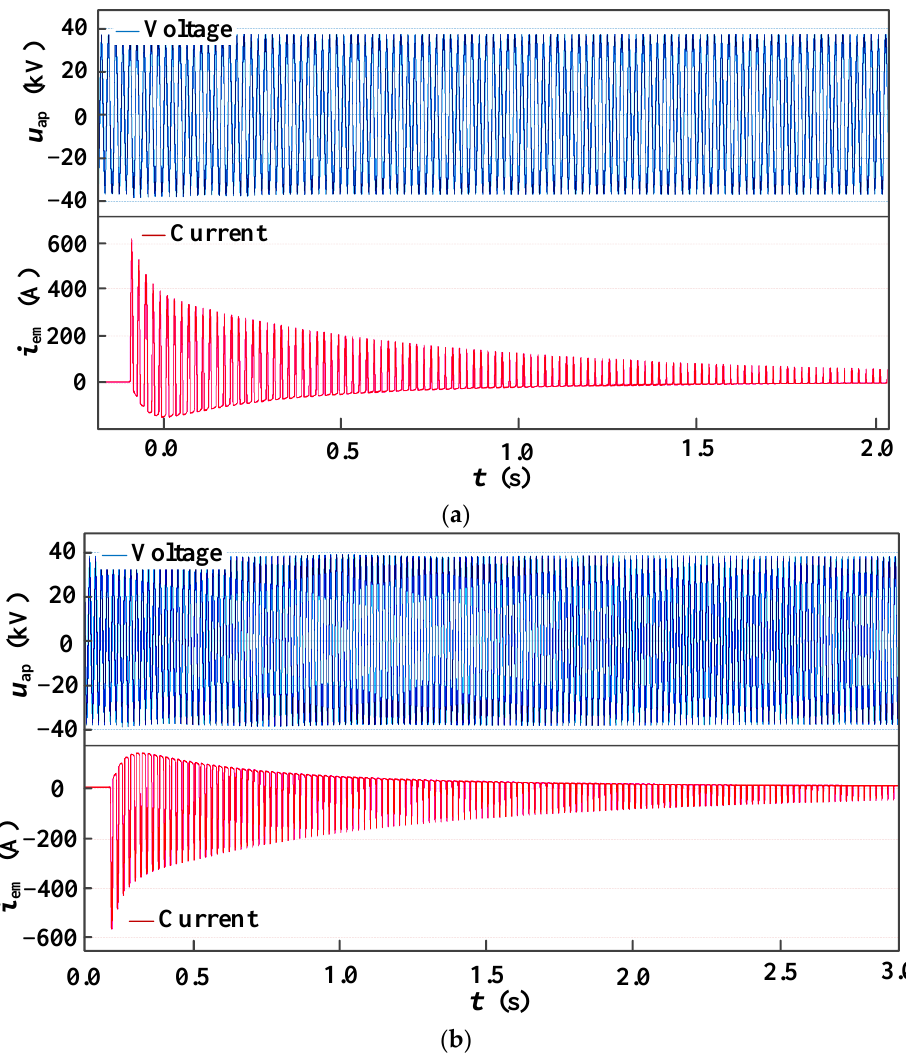
Figure 23. Network voltages and current waveforms at the pantograph when the breaker is closed. ( a ) Inrush current under the closing condition (in the forward direction). ( b ) Inrush current under the closing conditions (in the reverse direction).